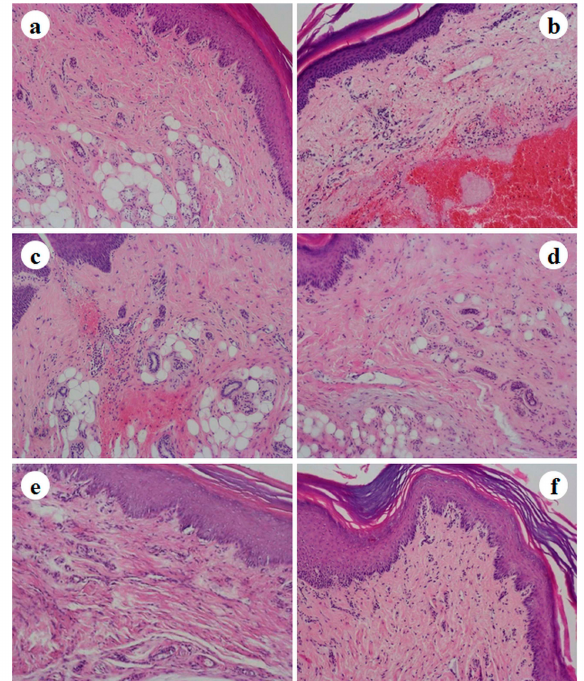
Figure 12. Representative photomicrographs from rat paw histological sections stained with H&E of ( a ) naïve control, ( b ) negative control, ( c ) etofenamate reference gel (Reumon ® Gel 5%), ( d ) etofenamate-SLN hydrogel, ( e ) ibuprofen reference gel (Ozonol ® 5%), and ( f ) ibuprofen-SLN hydrogel. Magnification: 100 ×